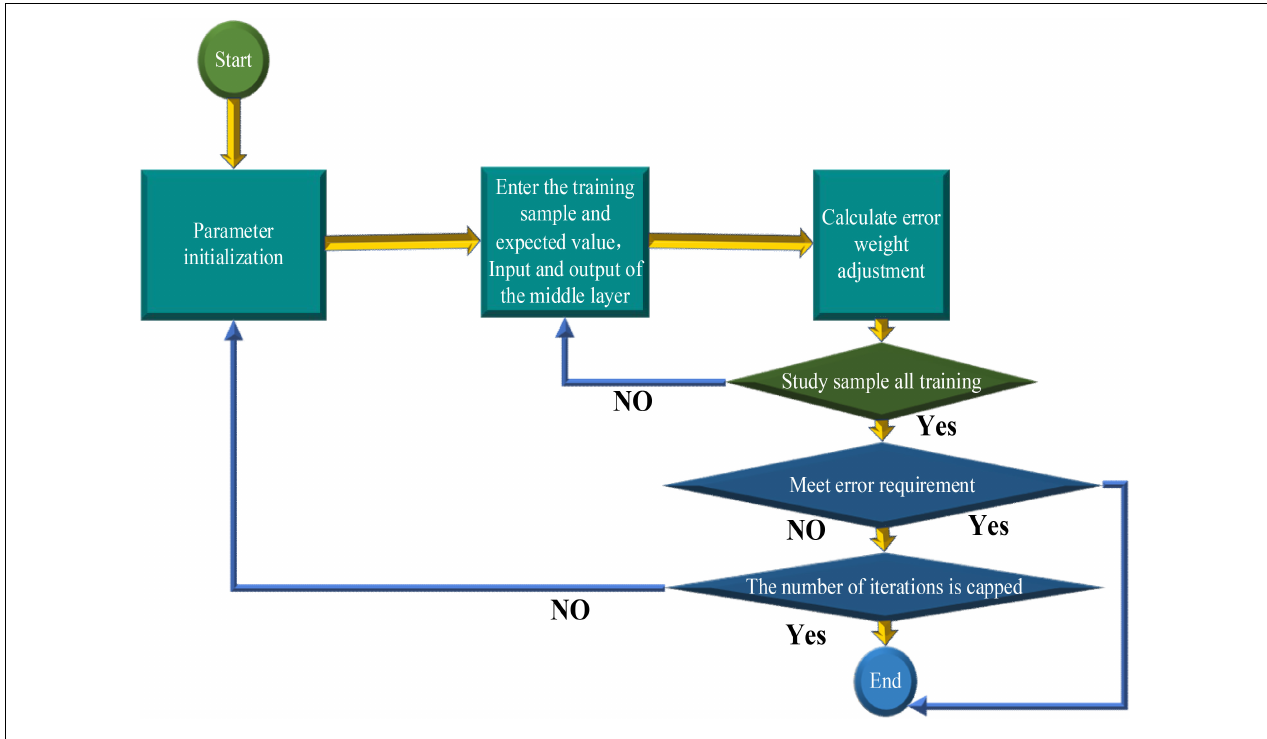
FIGURE 4 | Flowchart of the BPNN